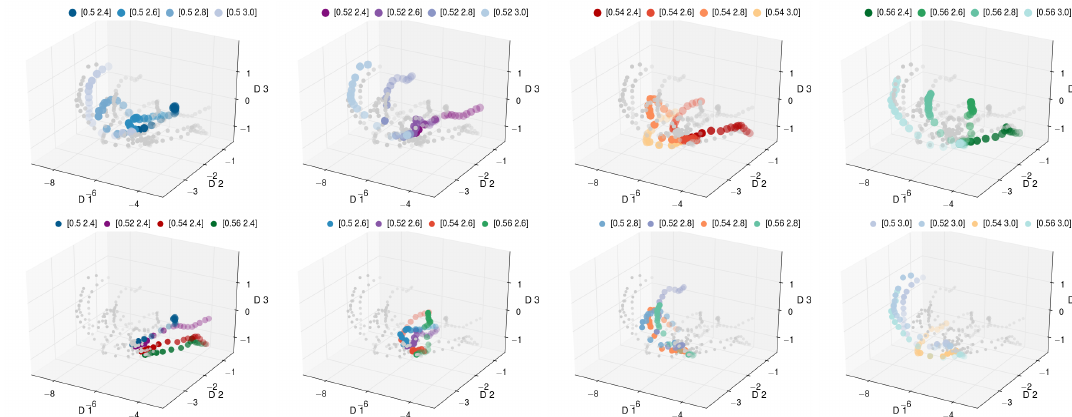
Figure 8. The manifold of the early stage of the morphology evolution with the first 30 points per trajectory. To better illustrate the discovered ordering by two variables, we color coded the same manifold according to increasing φ ( top ) and χ ( bottom ). (Please view in